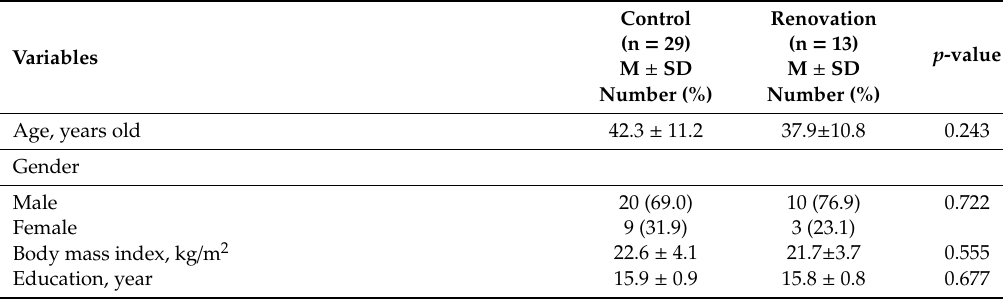
Table 1. Baseline characteristics in participants who wore